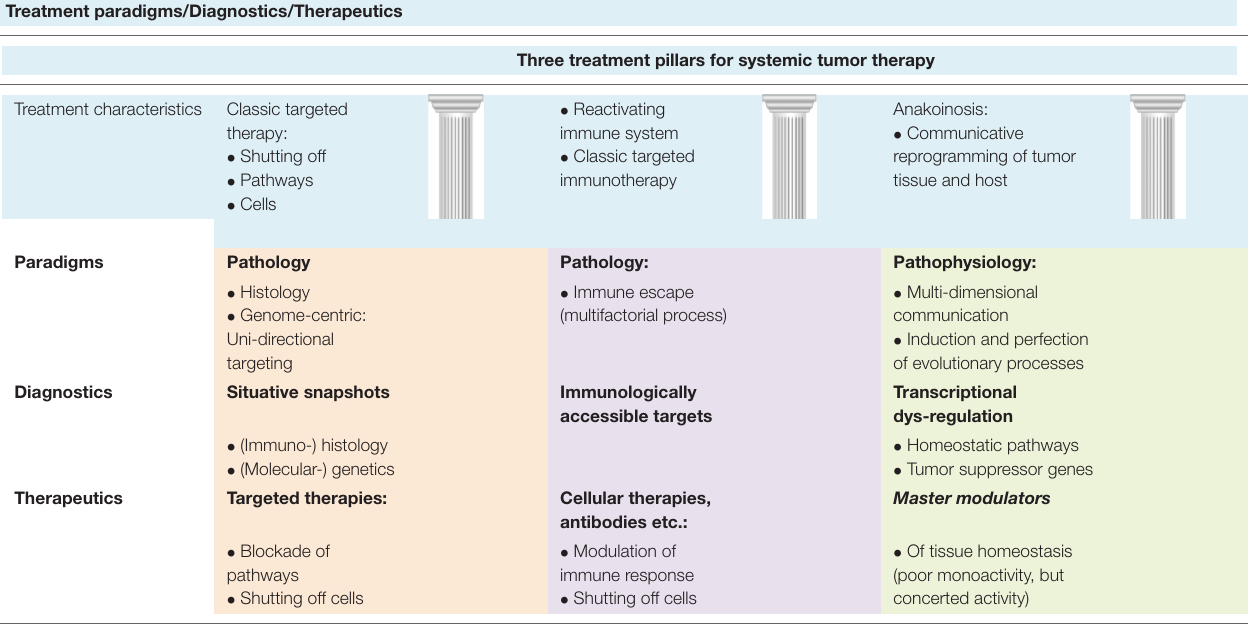
TABLE 2 | The tool of anakoinosis inducing therapies may be separated as novel treatment pillar. Treatment